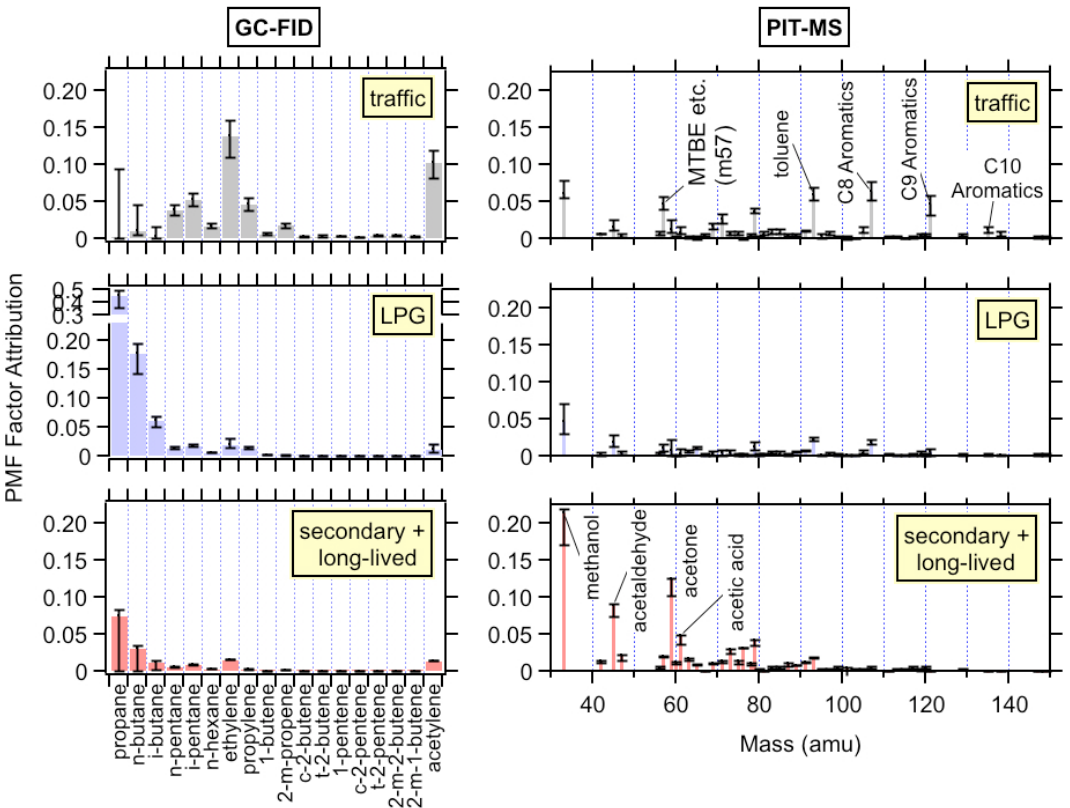
Fig. 9. PMF profiles are shown for compounds measured by the NOAA GC-FID (left column) and NOAA PIT-MS (right column) for the three factors, here labeled traffic, LPG, and secondary+long-lived species. Error bars represent the variation in PMF factors from the FPEAK 0 solution (solid bars) over the FPEAK range from − 3.0 to +3.0 as described in the text.